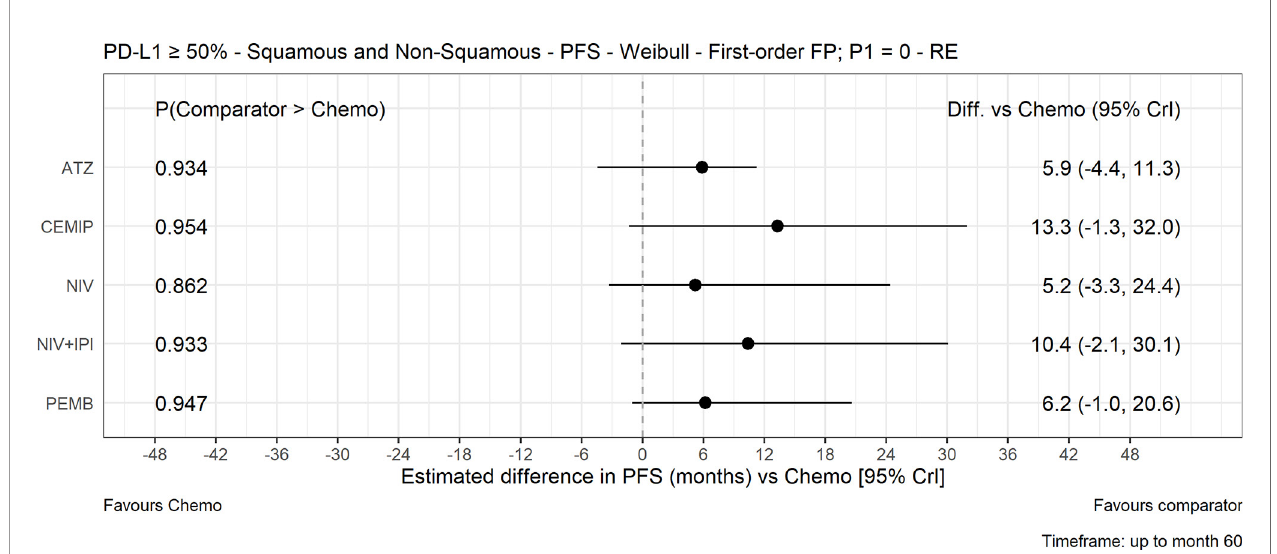
FIGURE 4 | Expected PFS difference with chemotherapy versus cancer immunotherapy comparators, mixed histology (60-month time horizon). Median posterior estimate and 95% posterior CrI. ATZ, atezolizumab; CEMIP, cemiplimab; chemo, chemotherapy; Diff., difference; NIV, nivolumab; NIV+IPI, nivolumab plus ipilimumab; PD-L1, programmed death-ligand 1; PFS, progression-free survival; PEMB, pembrolizumab; FP, fractional polynomial; P1=0, Weibull; RE, random effects.